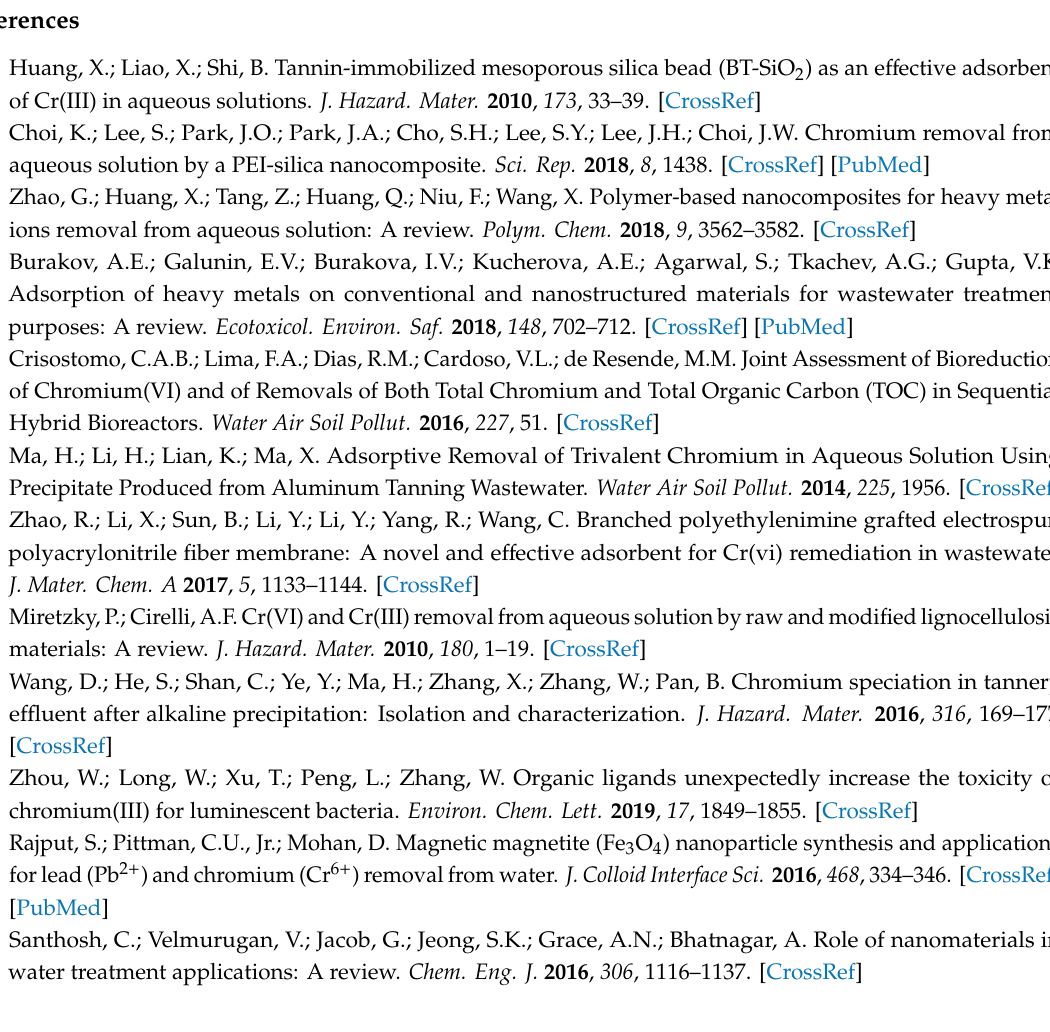
Figure S1: Absorption curves of TA solutions (0.8–2.0 mg L − 1 ) after reacting with ferric ion, Figure S2: Standard curve used for determining concentration of TA, Figure S3:TEM images of PAN nanofibers (a,c), PAN-TA-3 nanofibers(b,d) at di ff erent magnification, Figure S4: N2 adsorption-desorption isotherms of PAN nanofibers; the inset shows the BET surface areas of the nanofibers, Figure S5: The pseudo-first-order kinetic plots of adsorption kinetics on PAN-TA-3 NFs, Figure S6: Adsorption isotherms for Cr(III) adsorption (the inset is the corresponding Freundlich plots of Cr(III) on PAN-TA-3 NFs, Figure S7: Graph of lnK and 1000 / T for the adsorption of Cr(III) on PAN-TA-3 NFs, Figure S8: SEM image of PAN-TA-3 NFs after the five cycles adsorption-desorption, Figure